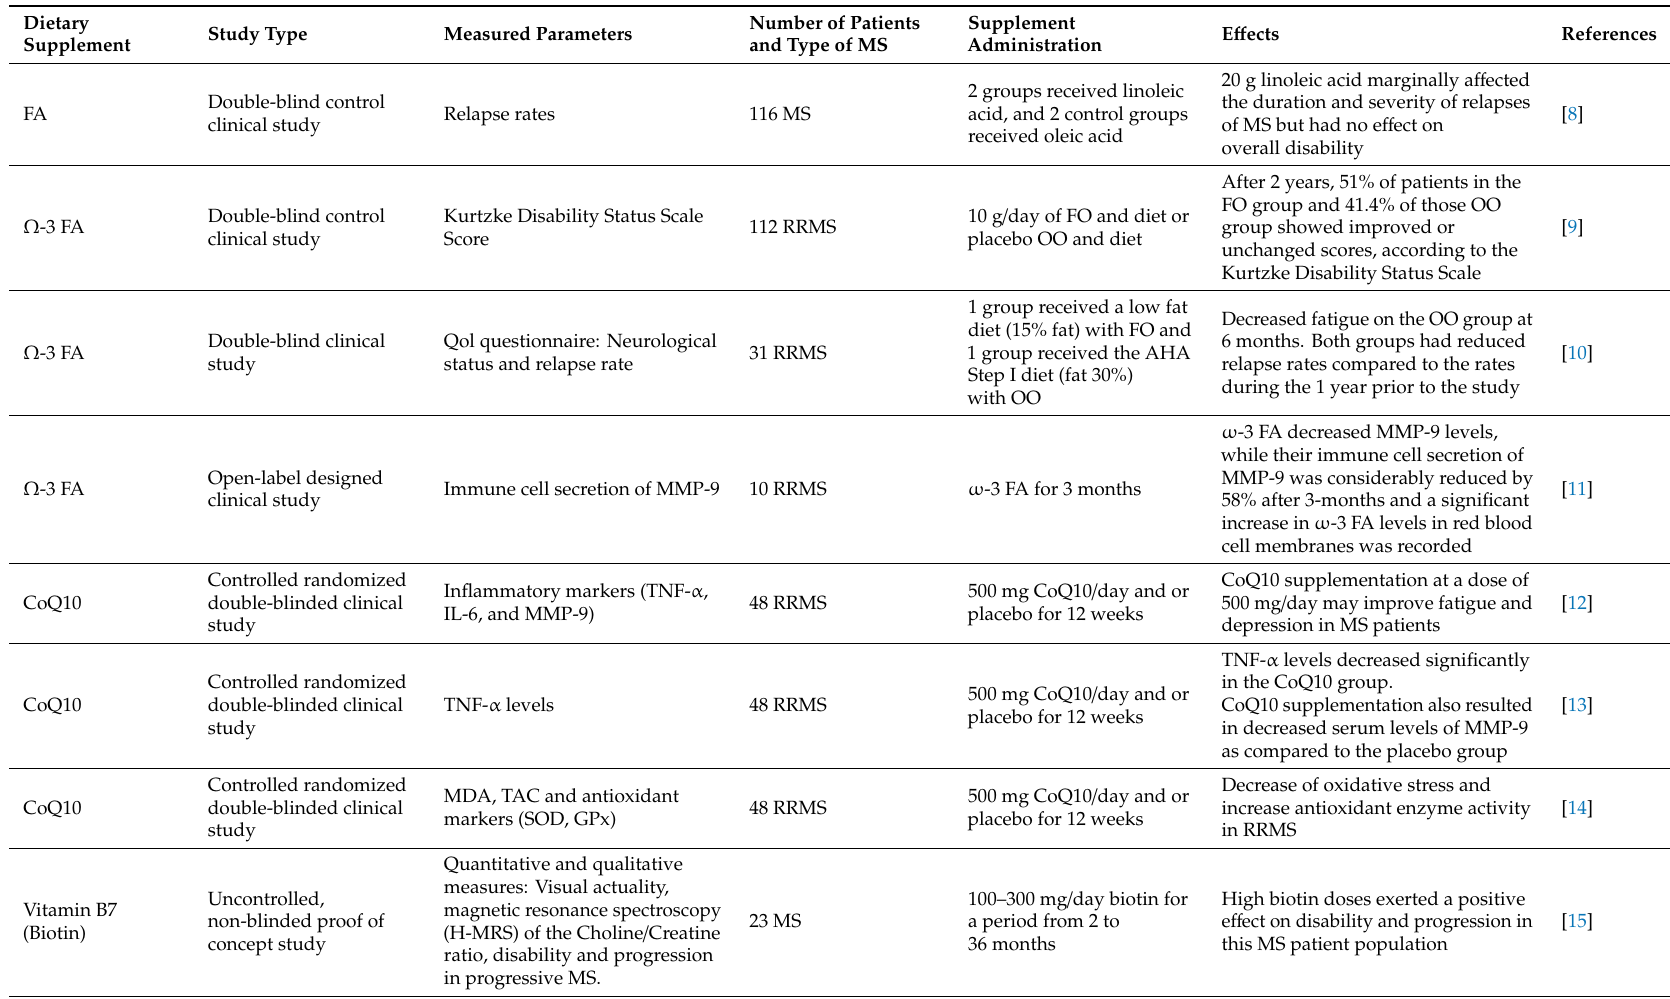
Table 1. Supplements that present beneficial e ff ects against multiple sclerosis symptoms and